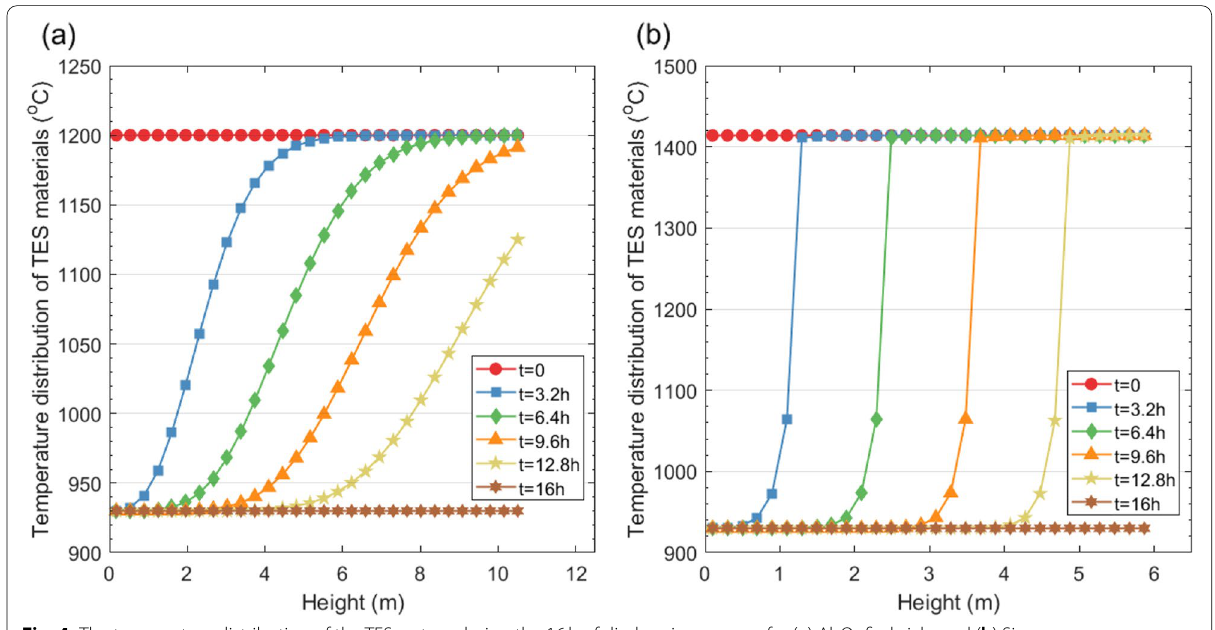
Fig. 4 The temperature distribution of the TES system during the 16 h of discharging process for ( a ) Al 2 O 3 firebricks and ( b )